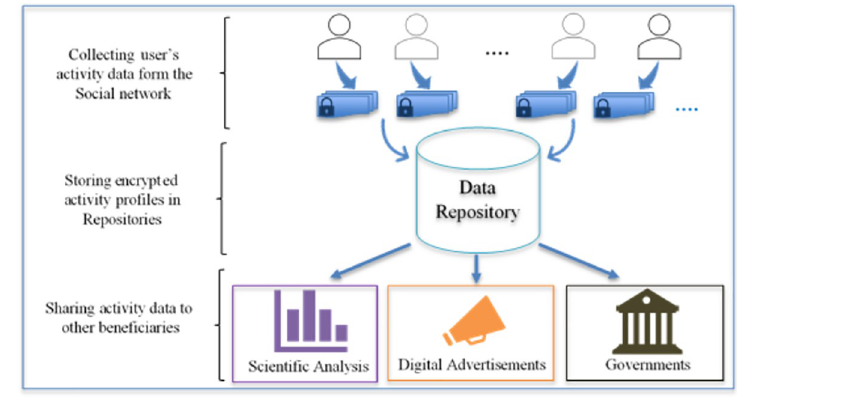
Fig 1. Data collection and sharing in an